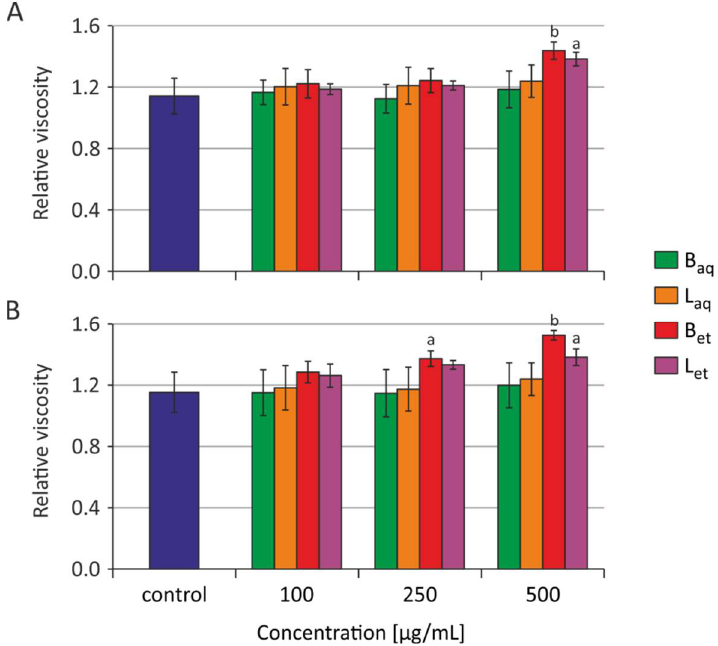
Figure 2. The relative internal viscosity of the erythrocytes incubated with extracts from U. tomentosa for 2 h ( A ) and 24 h ( B ) (abbreviations as in Figure 1); a p < 0.05 vs. control, b p < 0.01 vs.